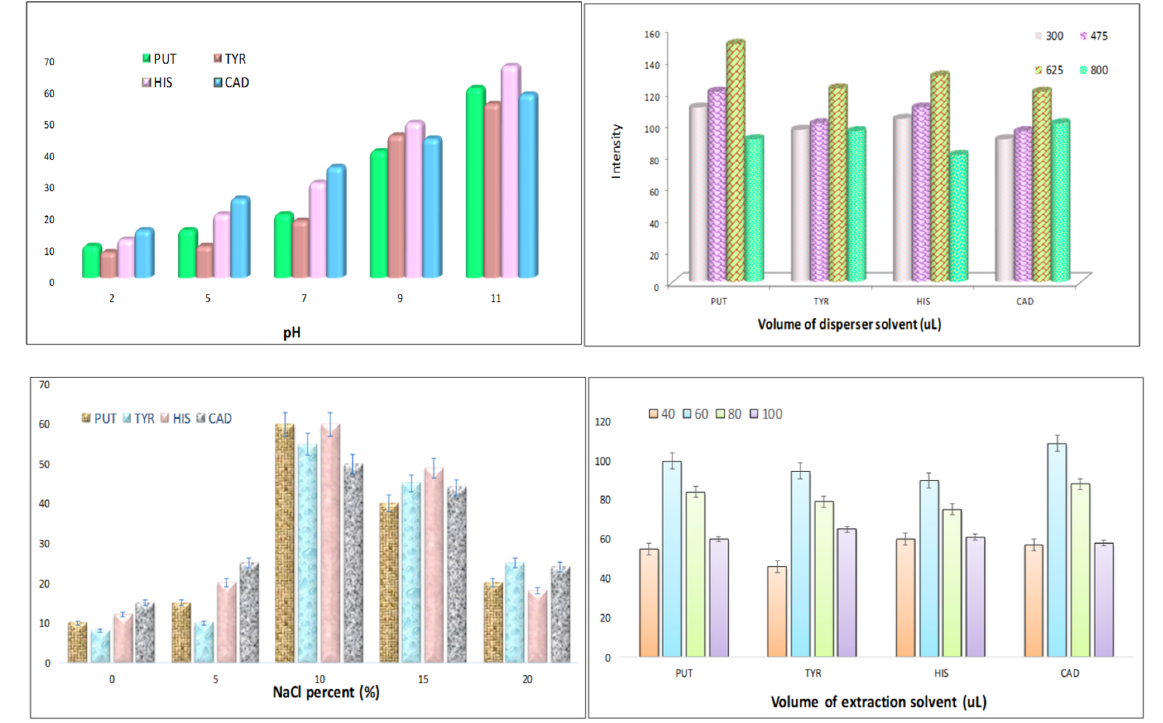
Figure 2. Optimum pH, volume of dispersive solvent, NaCl percentage and volume of extraction solvent (micro-DLLME stage).